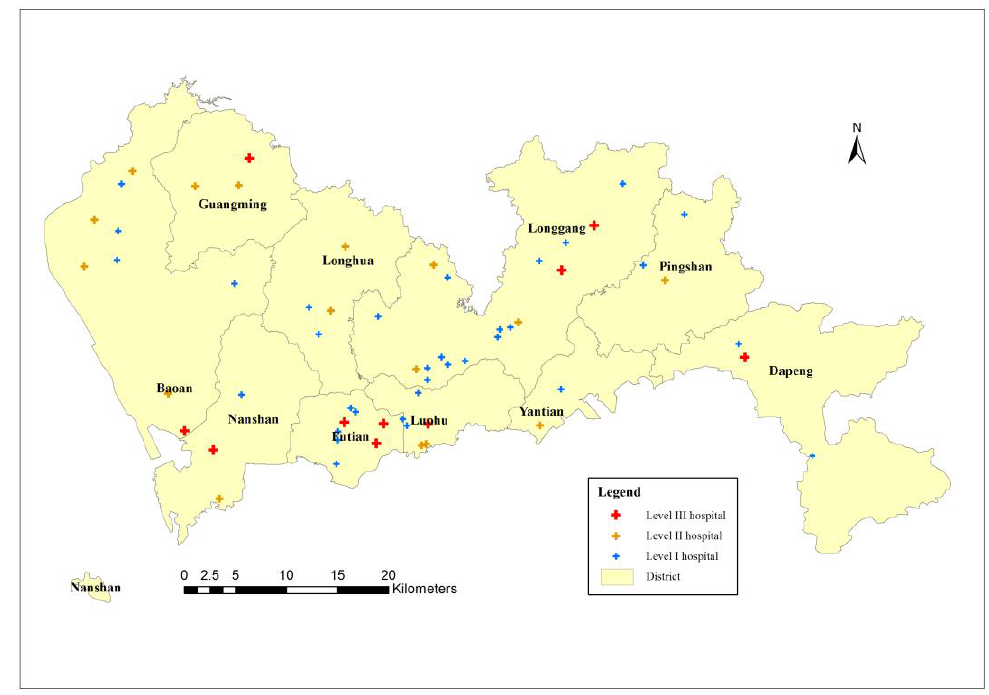
Figure 4. Distribution of candidate hospitals in Shenzhen. Table 2. Numbers of candidate hospitals in each district in Shenzhen.